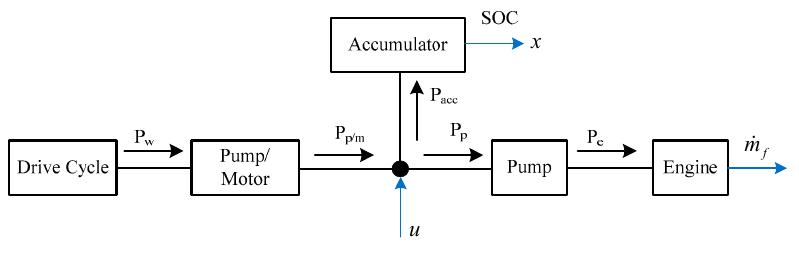
Figure 8. Backward Model of the SHHV.